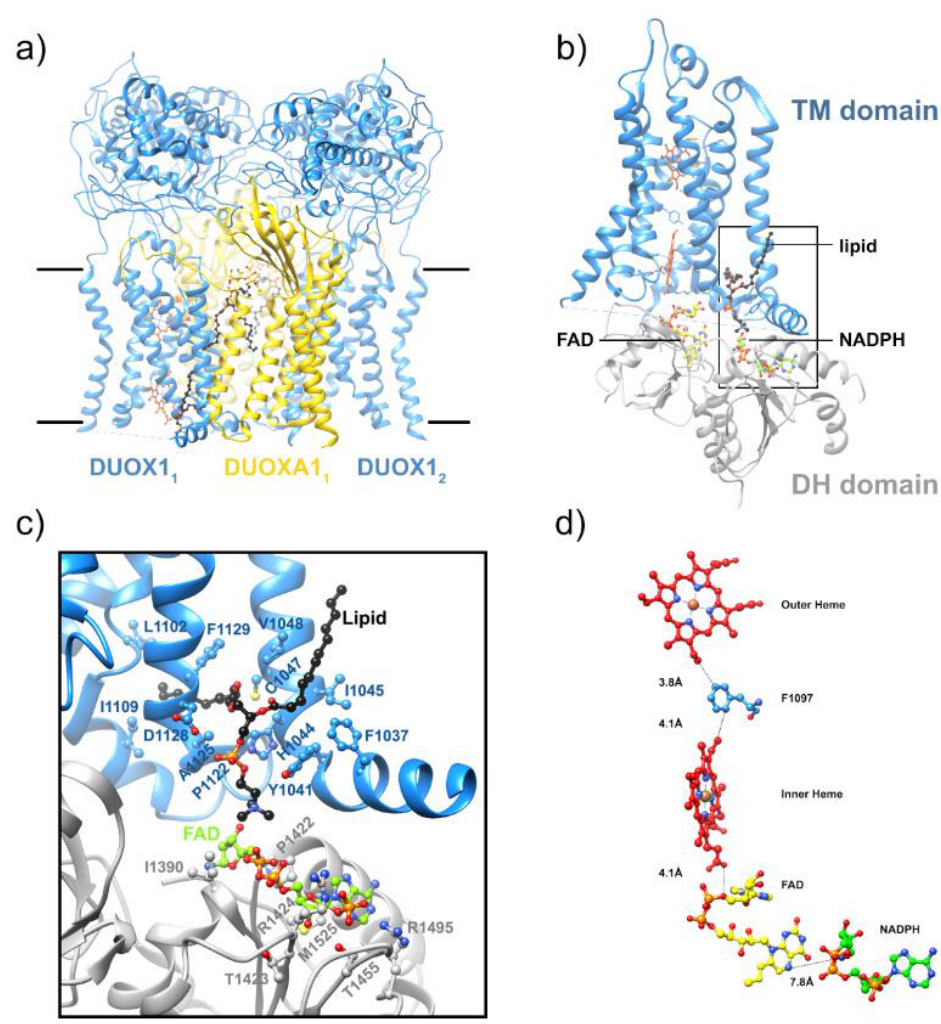
Figure 13. Structure of the mouse DUOX1/DUOXA1 complex solved by cryoEM in the inactive dimer of dimer configuration (3.2 Å) and in an active heterodimer state with NADPH at, respectively, (3.3 Å). ( a ) The structure of DUOX1 is displayed in blue and the structure of DUOXA1 is displayed in yellow. In the dimer of dimer configuration, the cryo-EM map allowed modeling of extracellular domains and TM domains, whilst cytoplasmic domains were too flexible to be resolved. ( b ) The TM domain of the active heterodimer state is displayed in blue and the DH domain is displayed in gray. The FAD, NADPH and nearby lipid molecules are shown as sticks and balls and colored in yellow, green and black, respectively. ( c ) The insert corresponds to the frame in black present in b) and provides a close-up view showing the interactions in the region of the lipid-mediated NADPH-binding site. ( d ) The electron transfer path deduced from the structure of the activated DUOX with calculated distances between players in the electron transfer path. Adapted from [65].